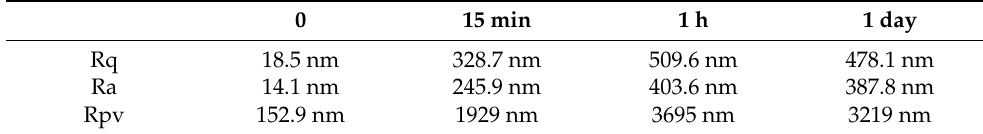
Table 2. Roughness parameters (Rq, Ra, Rpv) evolution with immersion